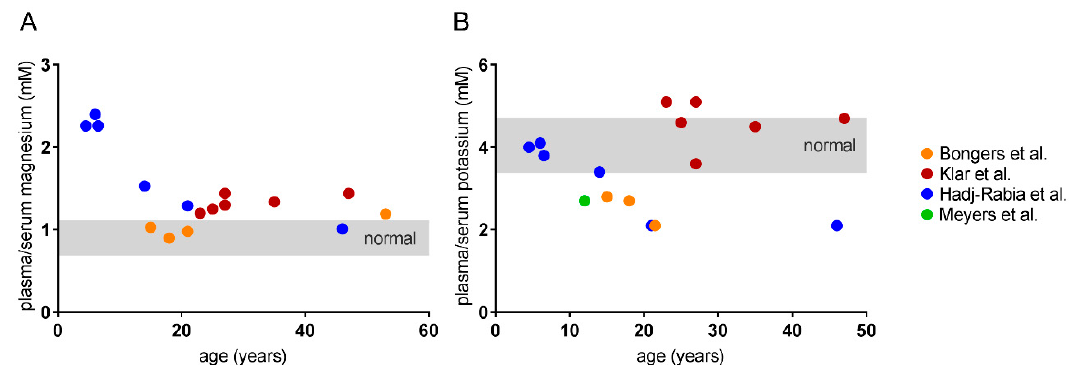
Figure 2. Available plasma/serum values of patients plotted against their age. ( A ) Hypermagnesemia is most pronounced in children and decreases with age. ( B ) Plasma/serum potassium levels decline